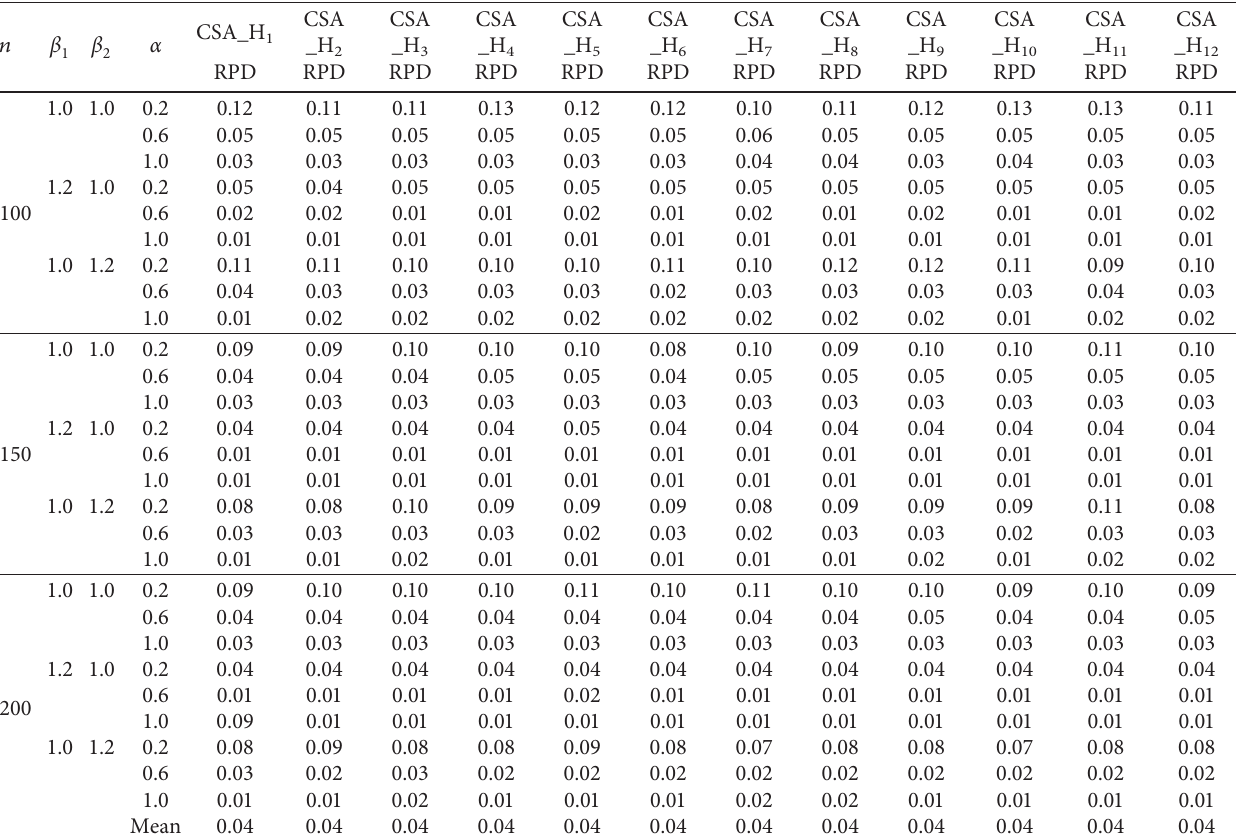
Table 5: The RPD of 12